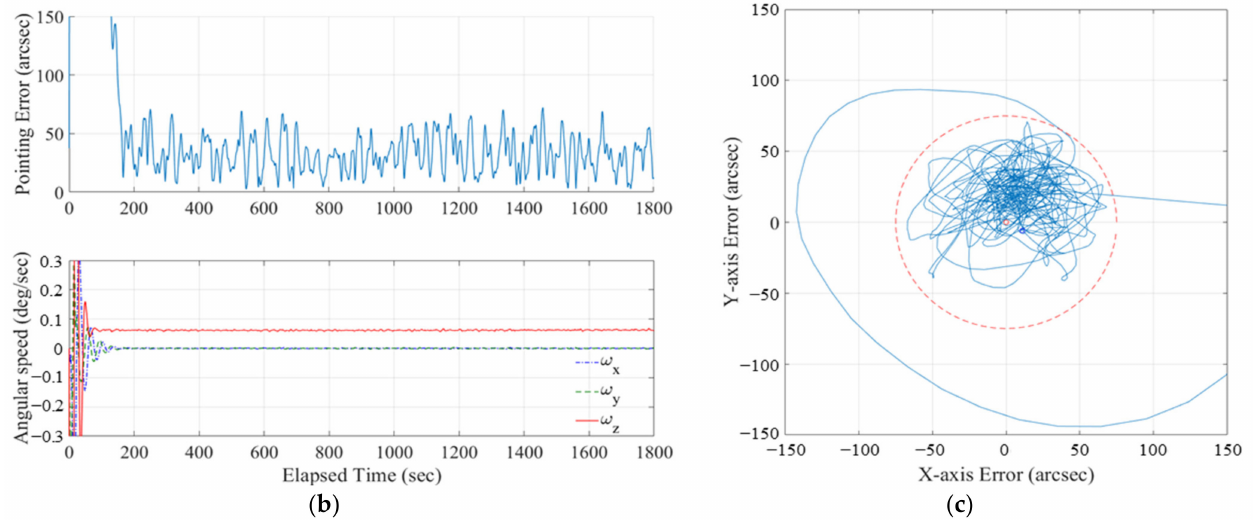
Figure 17. Diagrams and simulation results of the line-of-sight (LOS) errors for the PAT sequences: ( a ) LOS errors with uncertainties of relative navigation and body pointing can be corrected using angle-of-arrival (AOA) on tracking sensor (CAM); ( b ) body-pointing errors and angular velocity profiles in time-series; ( c ) body-pointing errors on a projected plane (body coordinated x-y).